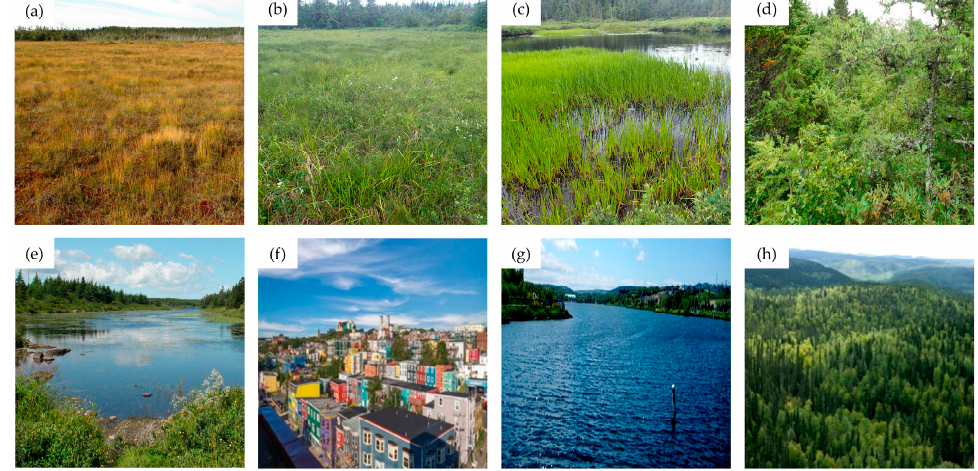
Figure 2. Examples of land cover classes in the Avalon study area, including ( a ) bog, ( b ) fen, ( c ) marsh, ( d ) swamp, ( e ) shallow water, ( f ) urban, ( g ) deep water, and ( h ) ( d ) swamp, ( e ) shallow water, ( f ) urban, ( g ) deep water, and ( h ) upland.